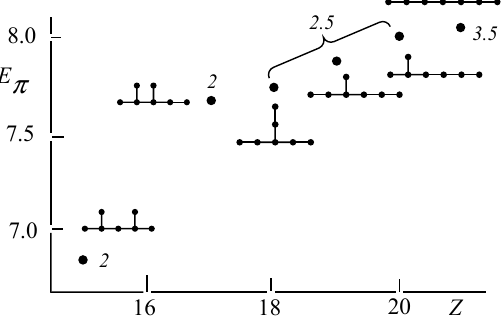
Figure 12. Z– E π plot of six isomers of C 7 H 9 conjugated radicals, among which only one isomer is a quartet radical.